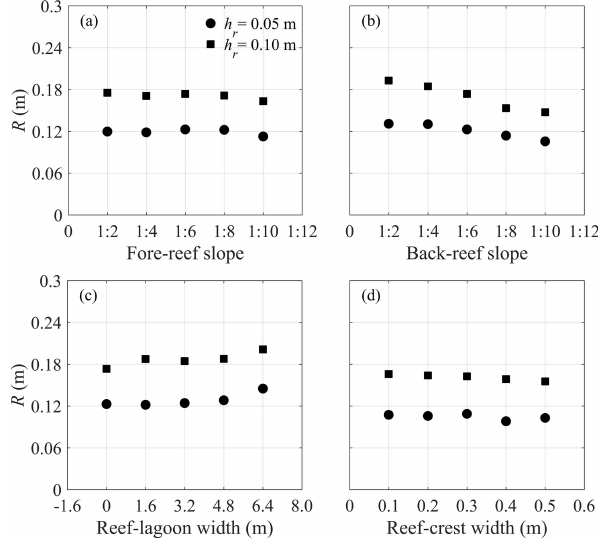
Figure 12. The predicted wave run-up on the back-reef beach ( R ) under H 0 = 0 . 08m with varying (a) fore-reef slopes, (b) back-reef slopes, (c) lagoon widths and (d) reef-crest